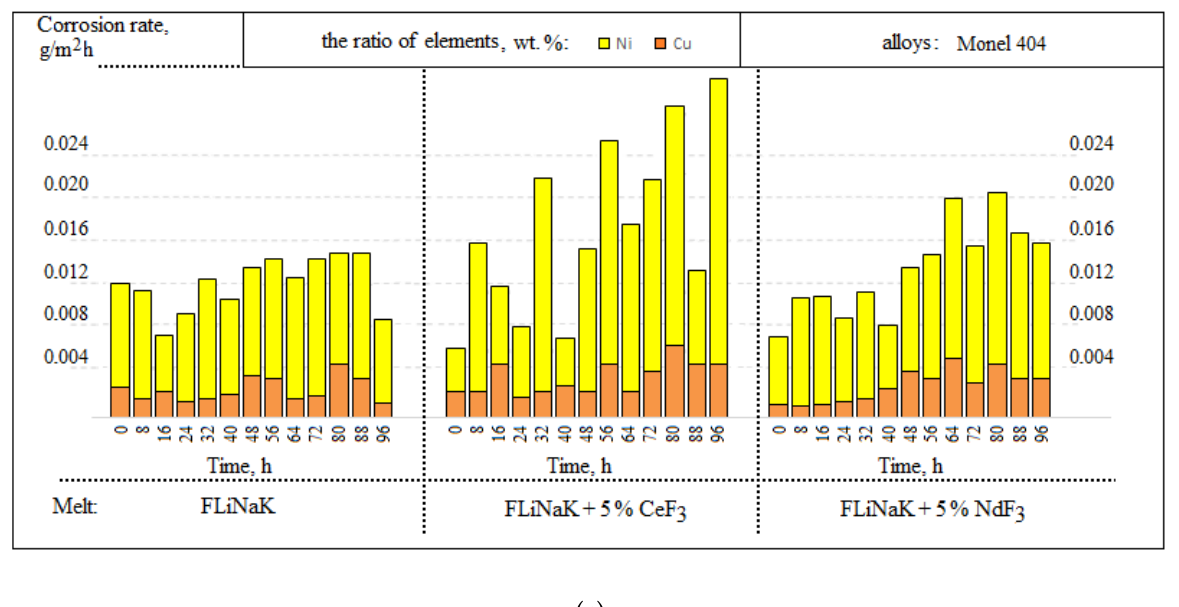
Figure 5. Sampling results of the studied alloys: ( a ) 12Cr18Ni10Ti; ( b ) Hastelloy C2000; ( c ) Monel 404.